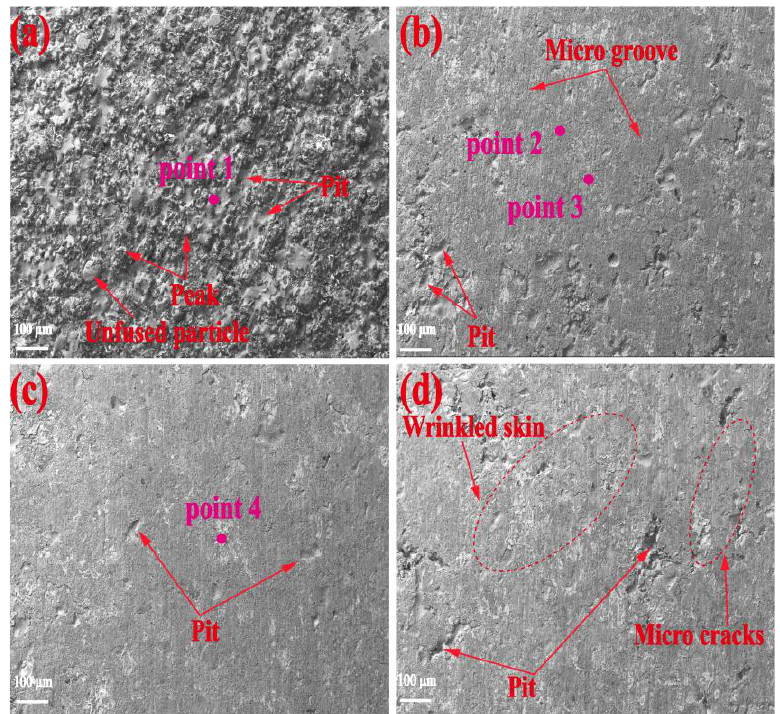
Figure 6. Surface morphology of preloading depth: ( a ) Untreated; ( b ) HT + UDR + 0.20 mm; ( c ) HT + UDR + 0.25 mm; ( d ) HT + UDR + 0.30 mm.